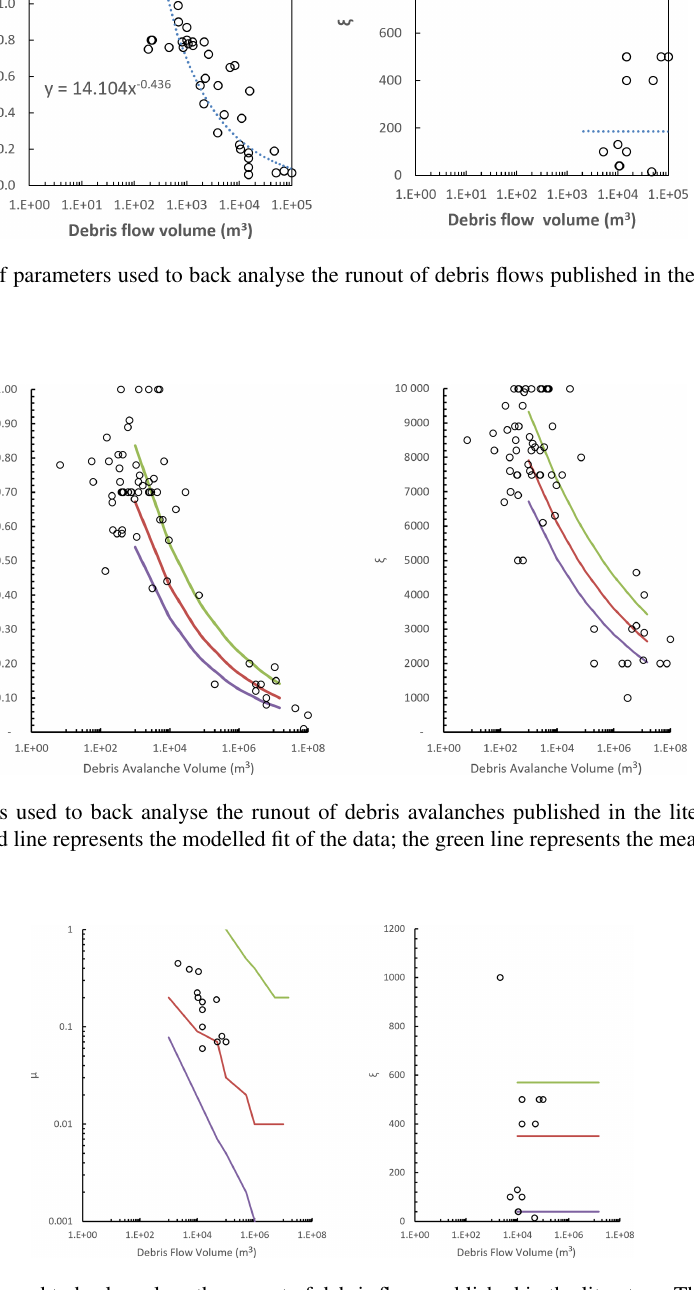
Figure C4. Range of parameters used to back analyse the runout of debris flows published in the literature. The fitted purple line represents the mean − 1 σ ; the red line represents the rounded parameters used within the simulation; the green line represents the mean + 1 σ